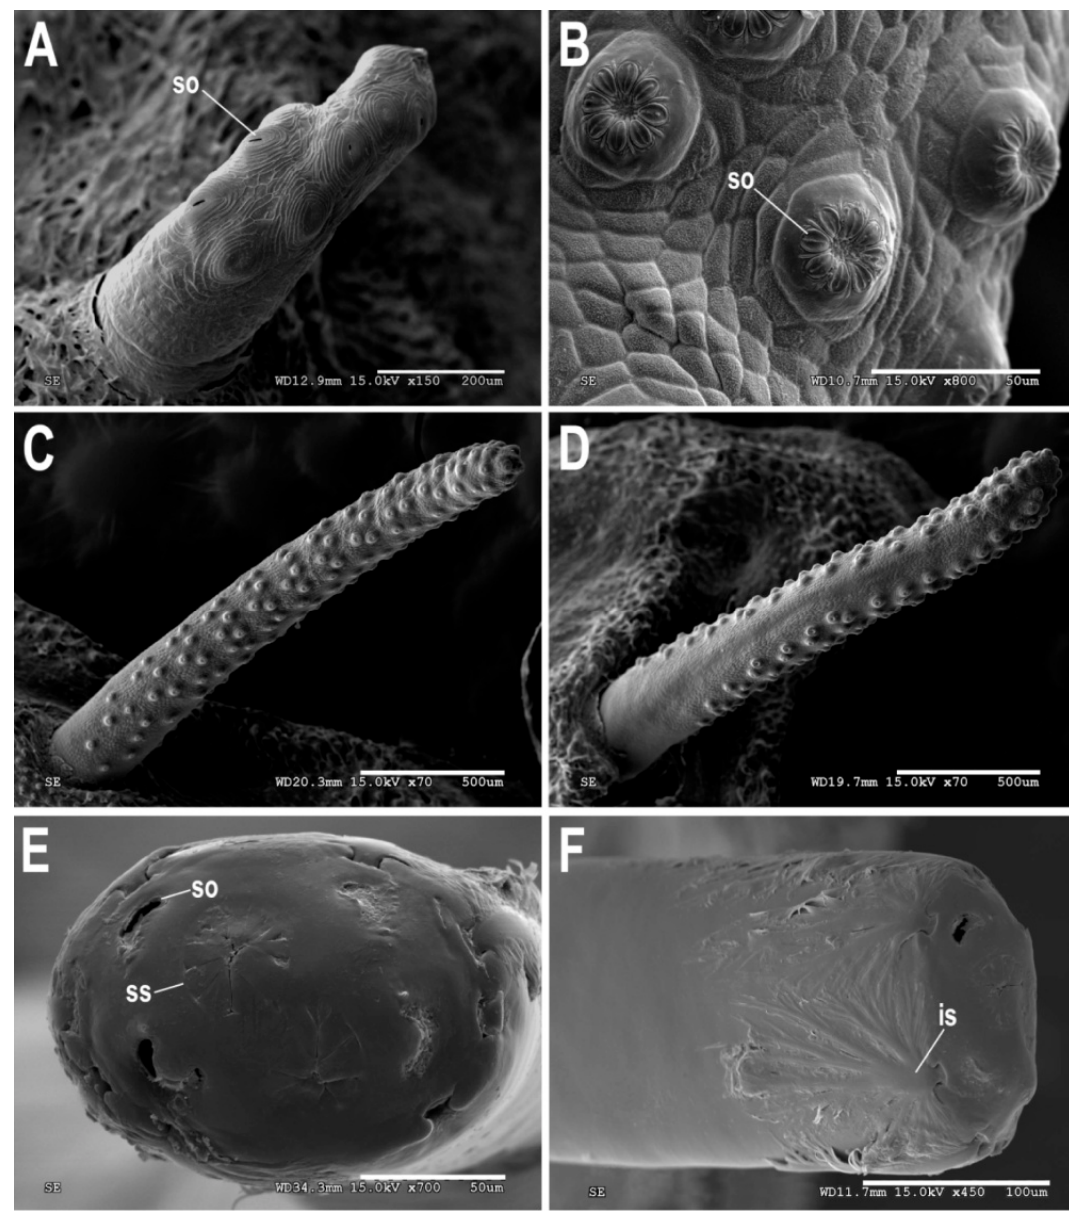
Figure 5. Meromacrus cactorum sp. nov., puparium. ( A ): anterior spiracle, ventral view. ( B ): tubercle with spiracular openings on a pupal spiracle. ( C ): pupal spiracle, dorsal view. ( D ): pupal spiracle, ventral view. ( E ): posterior respiratory process (PRP), apical view. ( F ): posterior respiratory process (PRP), dorsal view. Legend: so, spiracular opening; ss, spiracular scar; is, interspiracular setae.